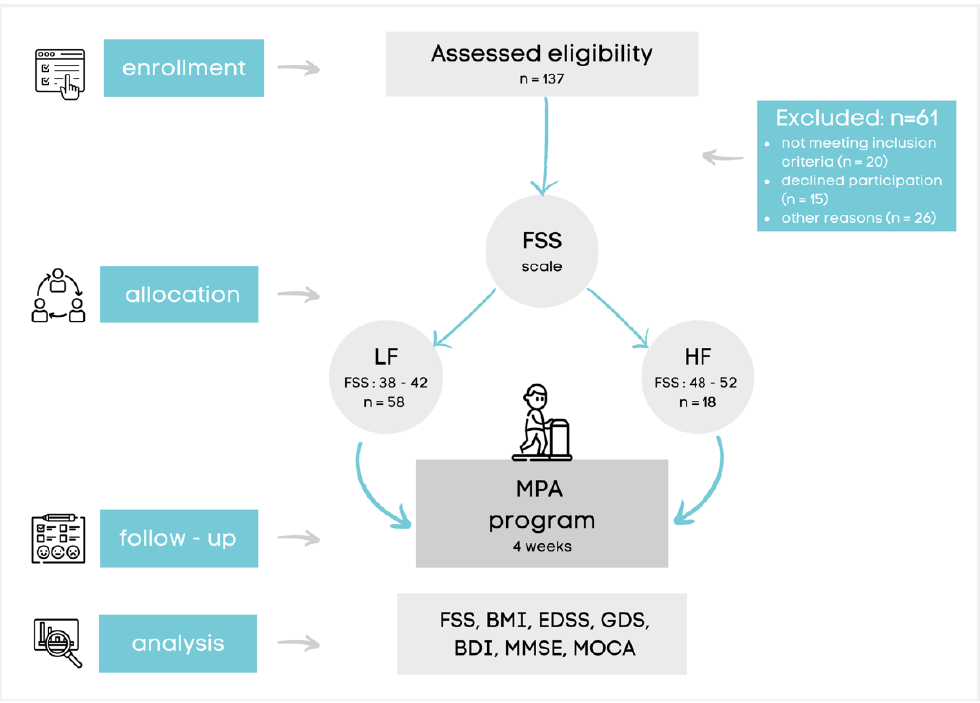
Figure 1. Process of the study. Table 1. Baseline characteristics of fatigued multiple sclerosis patients with high fatigue (HF) and low fatigue